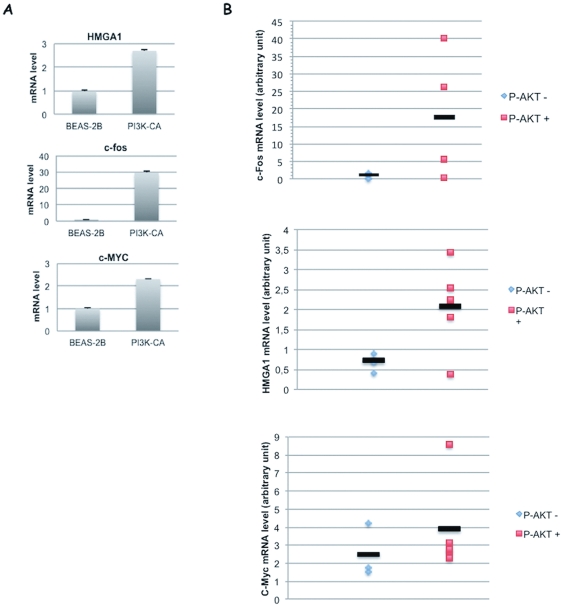
Activation of PI3KCA regulates expression of HMGA1, c-Fos, c-MYC in NSCLC cell lines.
A. Quantitative RT-PCR analysis of HMGA1, c-Fos, c-MYC gene expression in control BEAS-2B cells and in the corresponding cells transduced with active PIK3CA. B. Quantitative real-time RT-PCR analysis of c-Fos, HMGA1, c-Myc gene expression in different NSCLC cell lines.